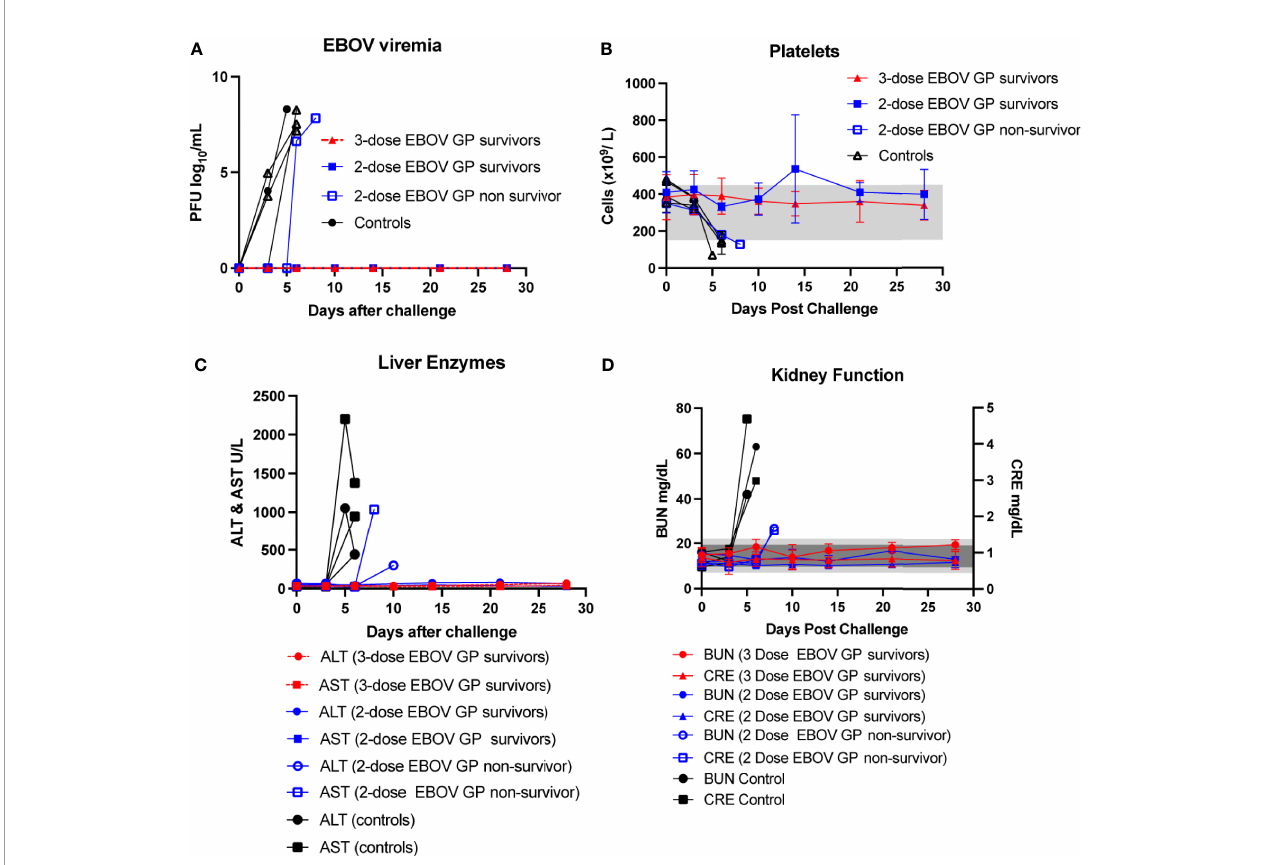
FIGURE 2 | Viremia, platelet counts, liver enzymes, and kidney function after EBOV challenge. (A) EBOV viremia as assessed by plaque assay. (B) Platelet counts with normal range of 150-450 x 10 3 cells/ m L shown as light grey band. (C) Serum ALT with normal range of 10-47 U/L and serum AST with normal range of 11-38 U/L. (D) Serum BUN with normal range of 7-22 mg/dL shown as light grey band and CRE with normal range of 0.6-1.2 mg/dL shown as darker grey band. Each data point for vaccinated survivor groups represents mean ± SEM. Data points for controls and the single two-dose non-survivor were plotted per individual